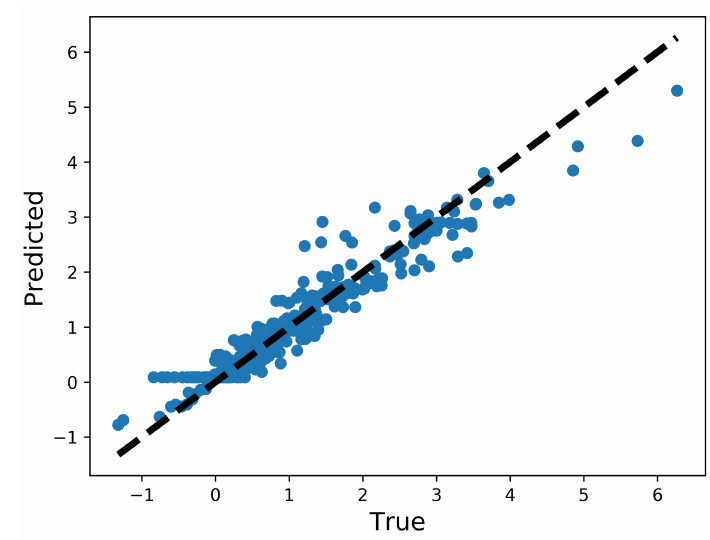
Figure 16. Performance of the trained model on the test set (FSI shape).